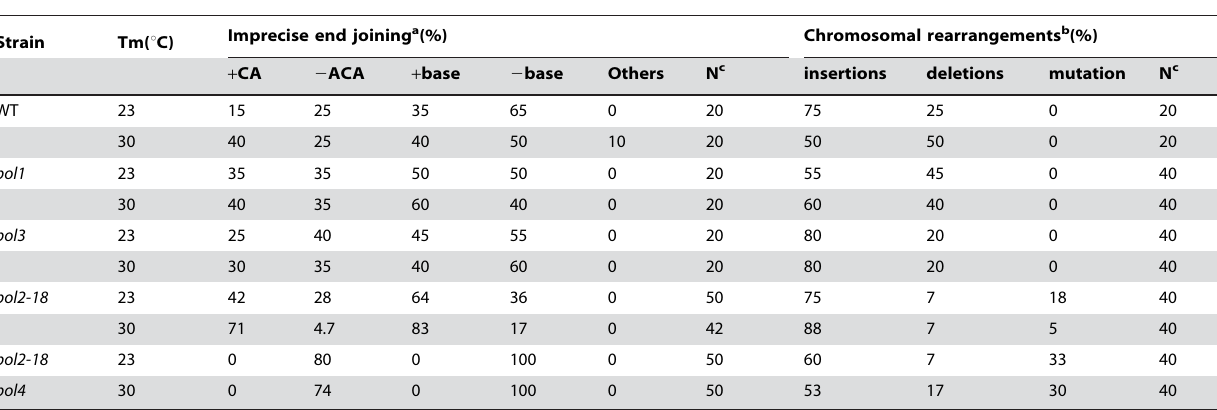
Table 2. Repair patterns after a DSB at the URA3 :: ACT1 intron::HO cut site locus of essential DNA polymerase mutants.